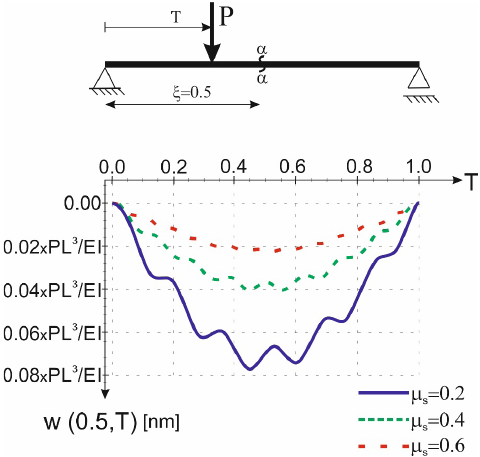
Figure 11: Strain gradient model. Vibrations of the beam in the middle cross-section if 0.05 g η =